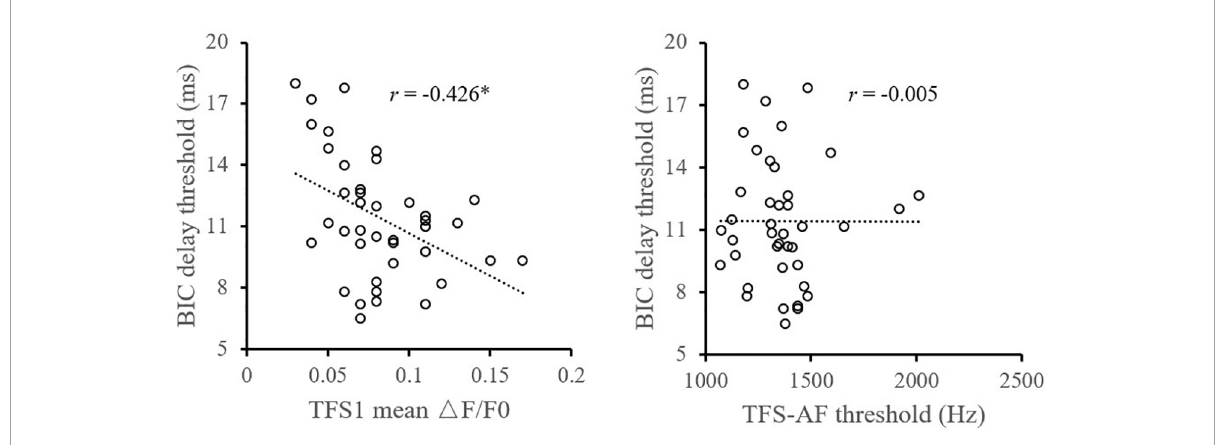
FIGURE2 Illustration of the correlation analysis of the BIC delay threshold and the TFS1 and TFS-AF test. ∗ Significant effect after Bonferroni’s correction, p <